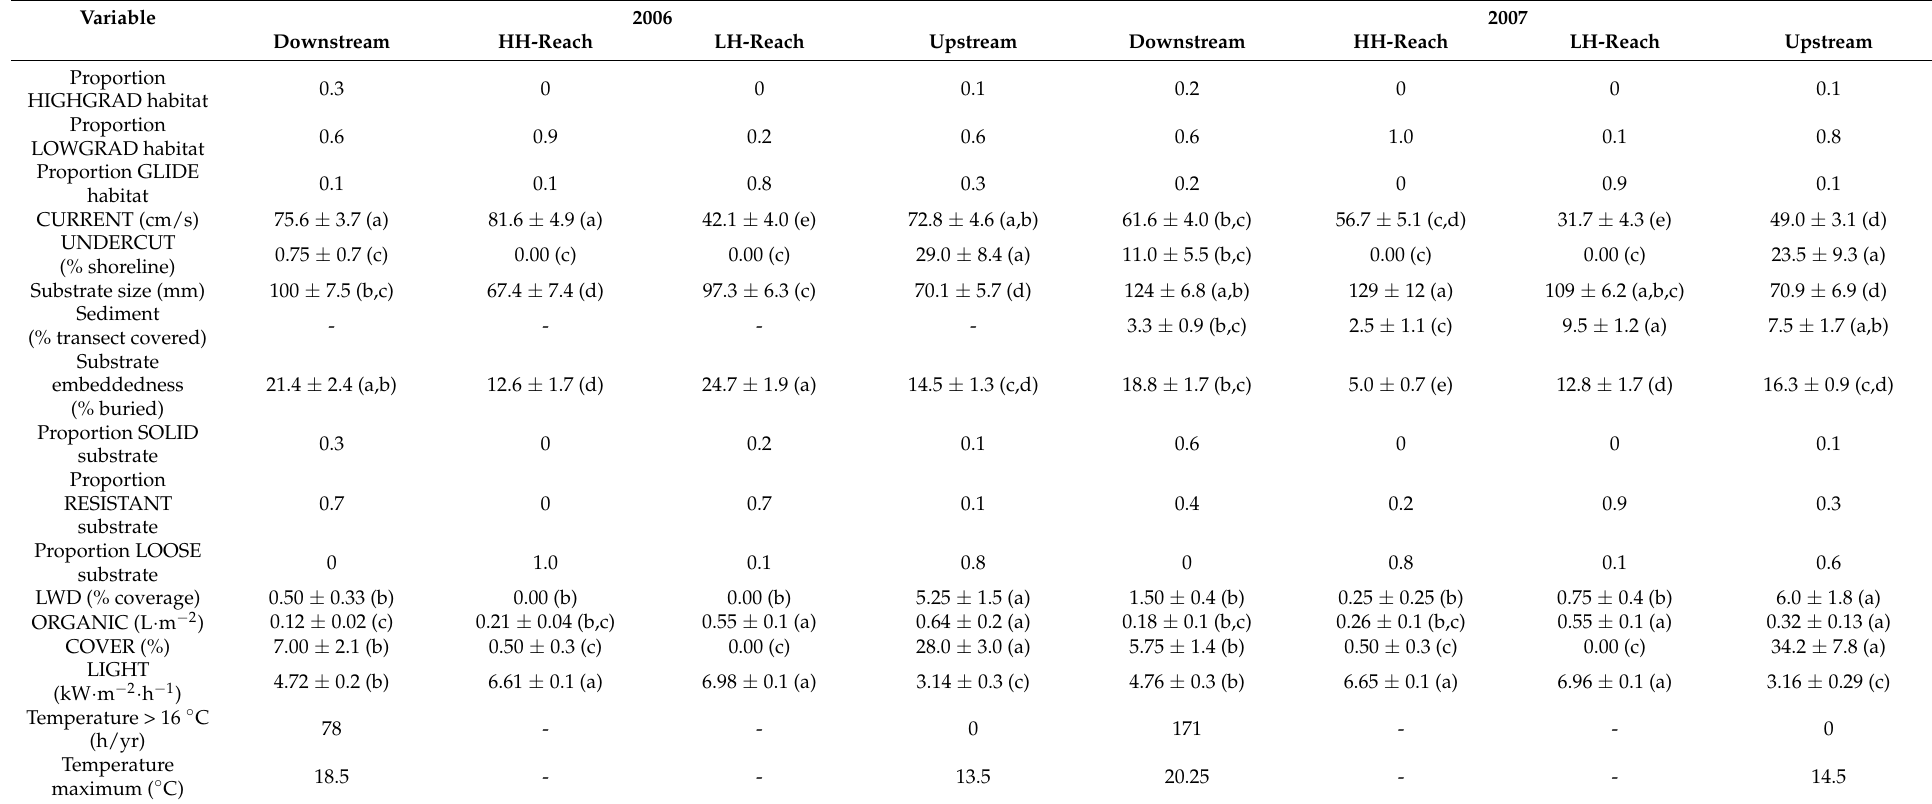
Table 1. Habitat results by year of sampling and reach. For quantitative variables, values reported are mean ± S.E. Groups with the same letter (i.e., a–e) are not significantly different ( α = 0.05) according to Duncan’s Multiple Range Test. For categorical variables, the proportion of transects in each categorical level is reported by group. Variable names are